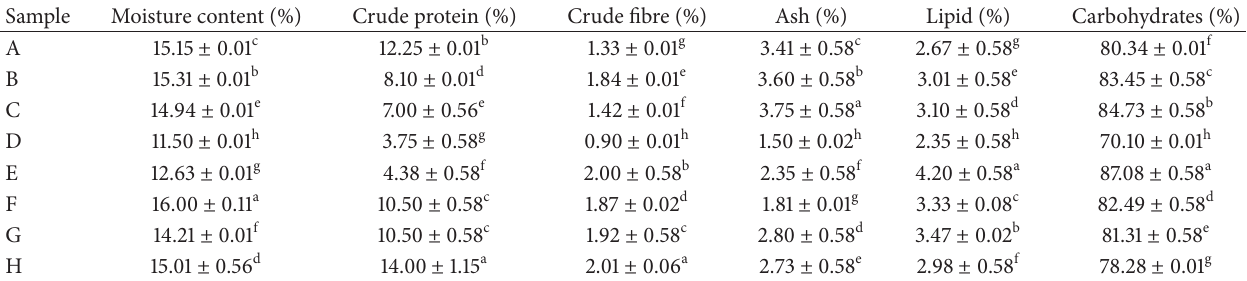
Table 3: Proximate composition of freshly baked bread.